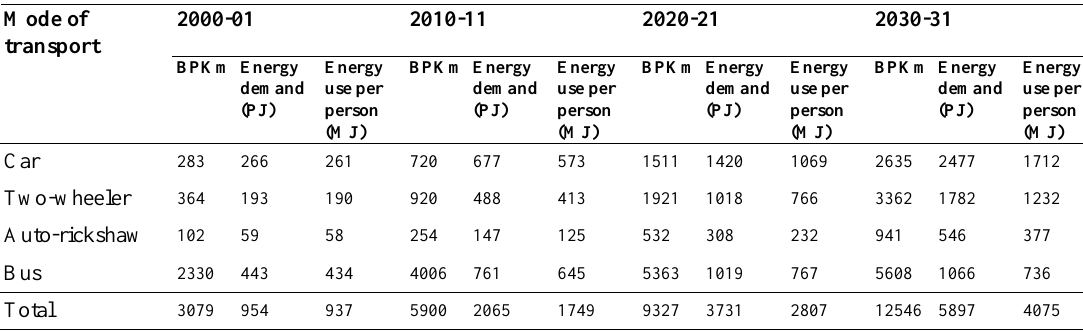
Table 6. Transport energy demand in India; business as usual